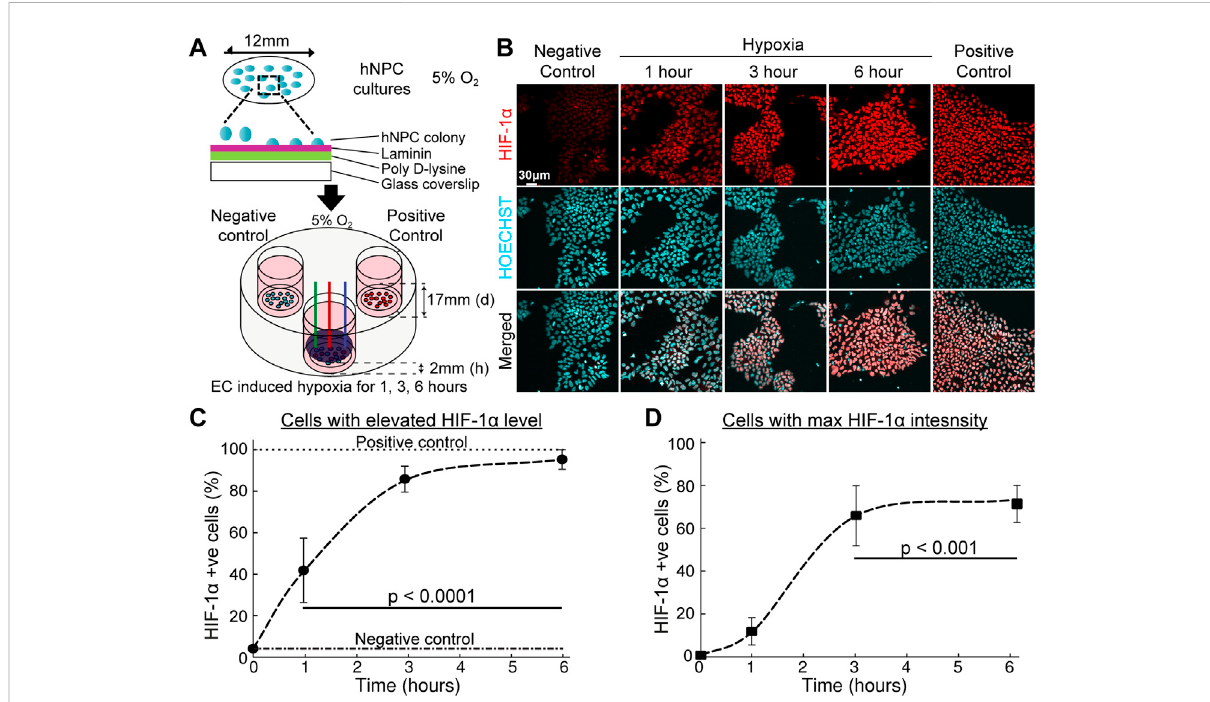
FIGURE 5 HypoxicresponseofhNPCsinelectrochemicalincubator. (A) SchematicprocedureofthepreparationofhNPCsandscavengingsystemset-up. (B) Representativeconfocalimagesofcellcultureswithimmuno fl uorescentstainingonHIF-1 α (red)andnucleus(blue). (C,D) Quantitativeanalysisof HIF-1 α response under long duration of hypoxic insult. ( n = 3, error bars indicate standard deviation). (C) Percentage of cells with HIF-1 α fl uorescent